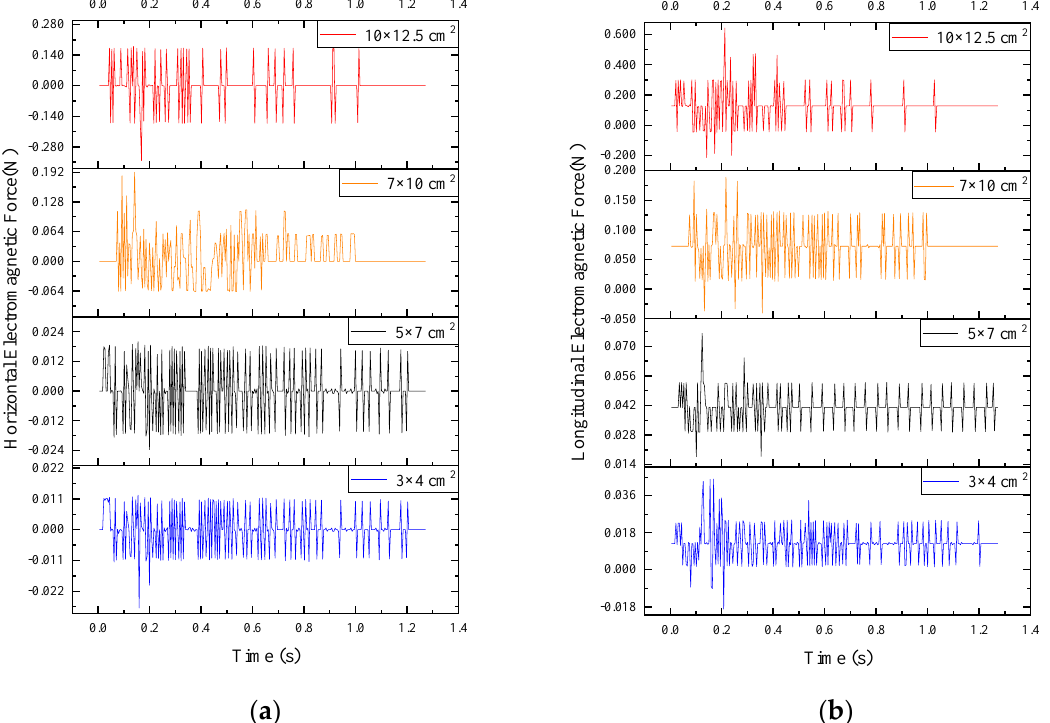
Figure 10. Electromagnetic force changes of four sizes of aluminum sheets. ( a ) Horizontal EMF of aluminum sheets; ( b ) longitudinal EMF of aluminum sheets.